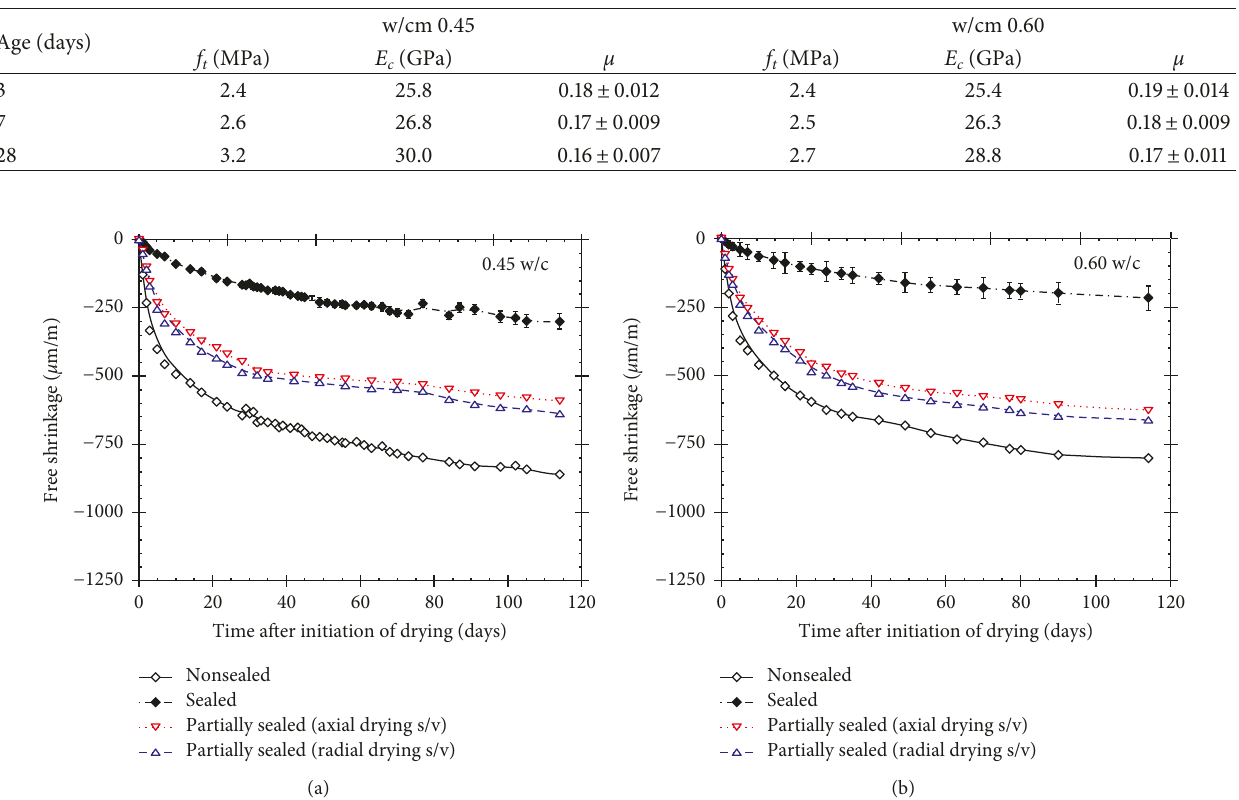
Table 3: Mechanical properties.